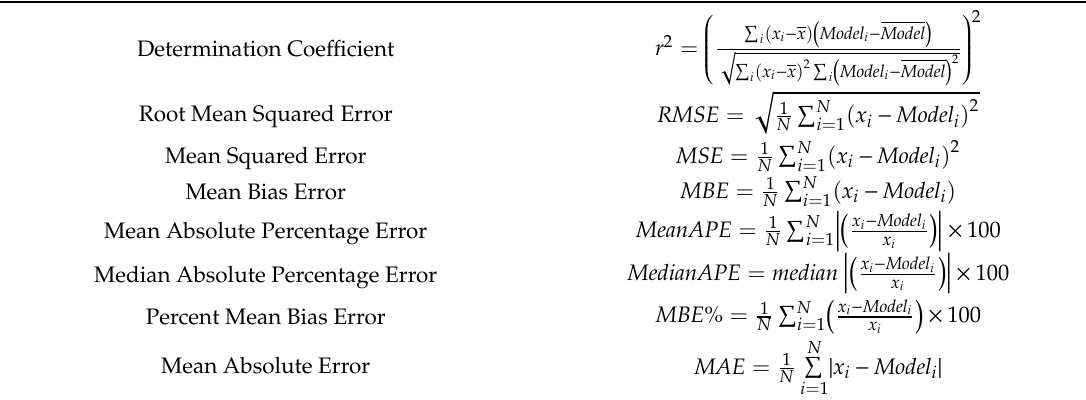
Table 1. Reference statistical parameters employed for the assessment of the Multi-Layer-Perceptron (MLP) performance with respect to the observed data. N is the number of observations and x is the observed